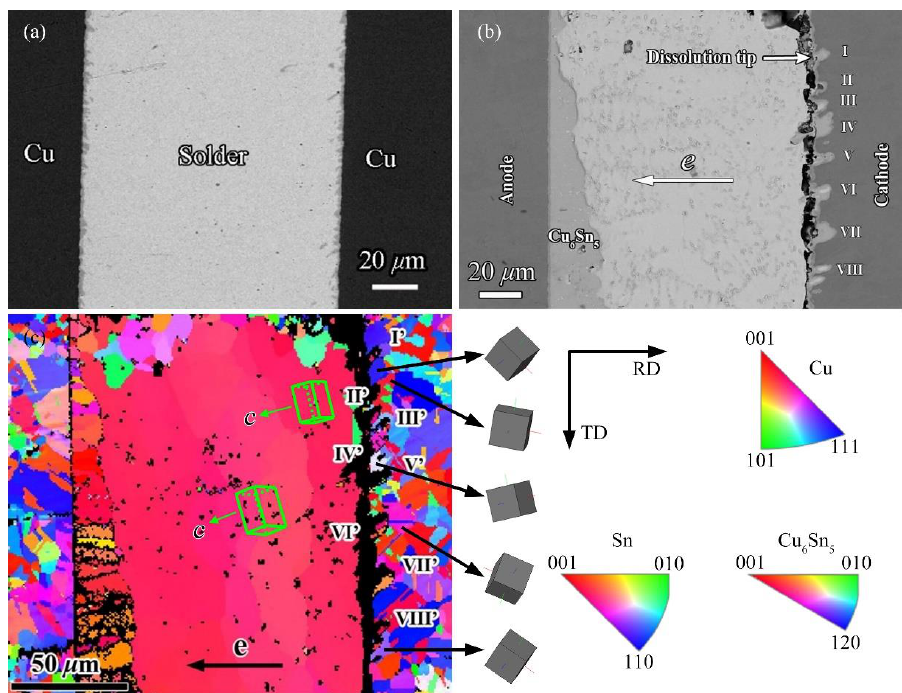
Figure 2. ( a ) As-reflowed Cu/SAC305/Cu joint; ( b ) a Cu/SAC305/Cu joint under the current stressing of 1.5 × 10 4 A/cm 2 at 125 °C for 200 h; ( c ) corresponding IPF-X color orientation maps in ( b ), I’ in ( c ) corresponding to I in ( b ), II’ to II, and so on.